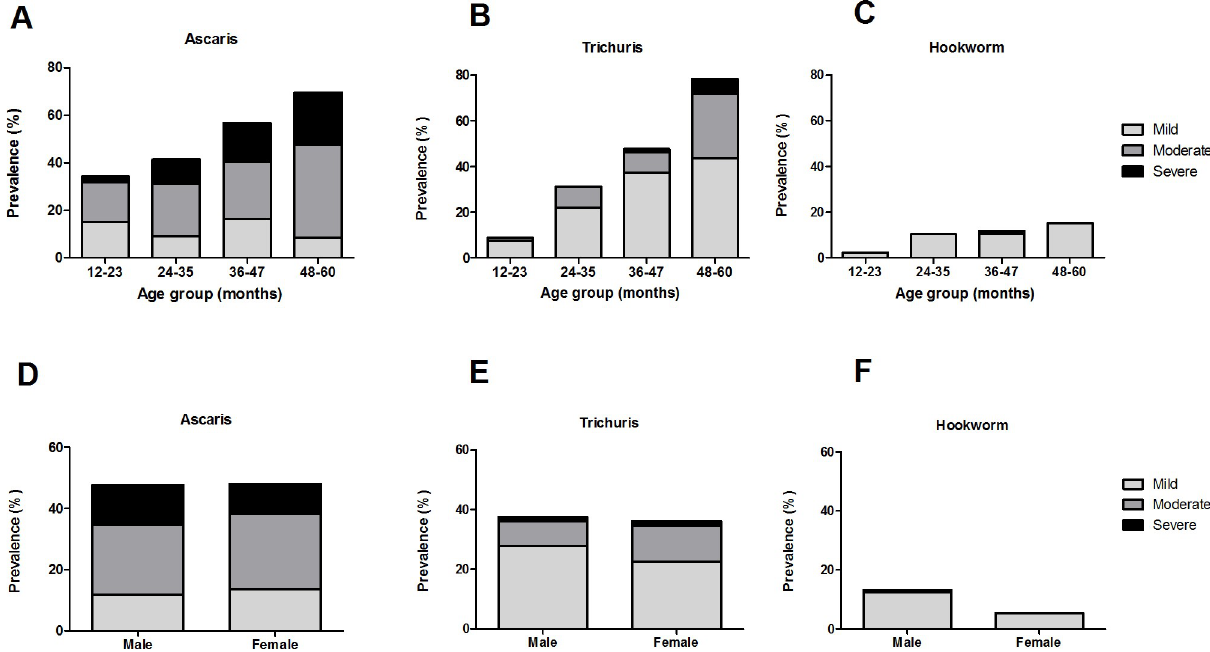
Fig 1. Prevalence and intensity of (A) A . lumbricoides , (B) T . trichiura , and (C) hookworm infections based on age groups, and (D) A . lumbricoides , (E) T . trichiura , and (F) hookworm infections based on sex.